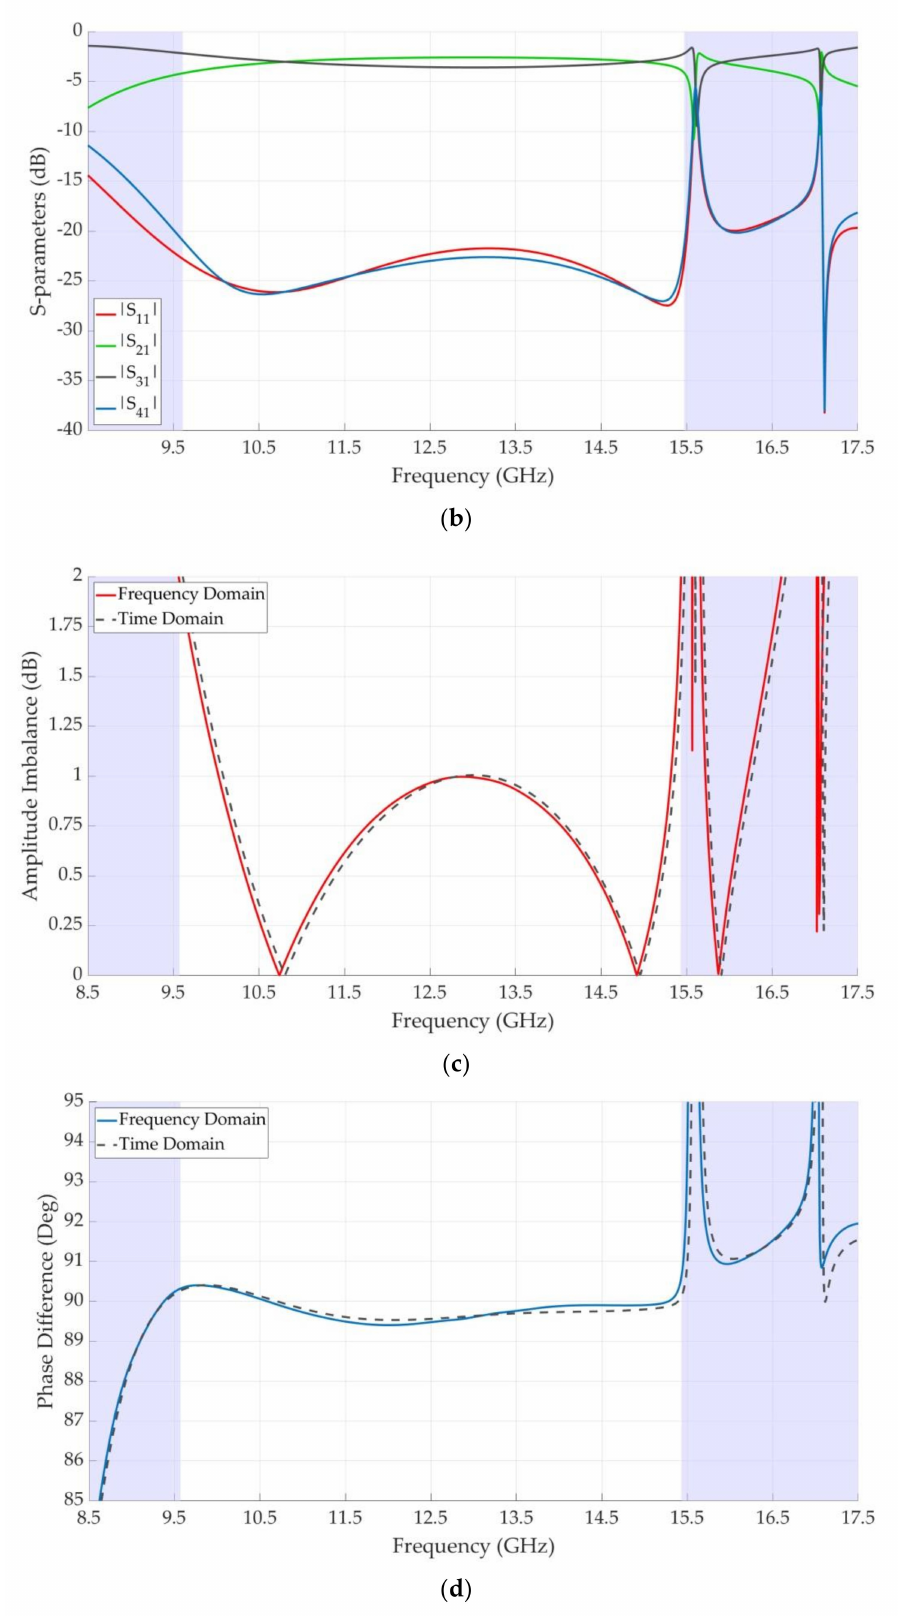
Figure 4. Hybrid coupler 2 (HC2) simulated performance. ( a ) Frequency-domain scattering parame- ters. ( b ) Time-domain scattering parameters. ( c ) Amplitude imbalance. ( d ) Phase